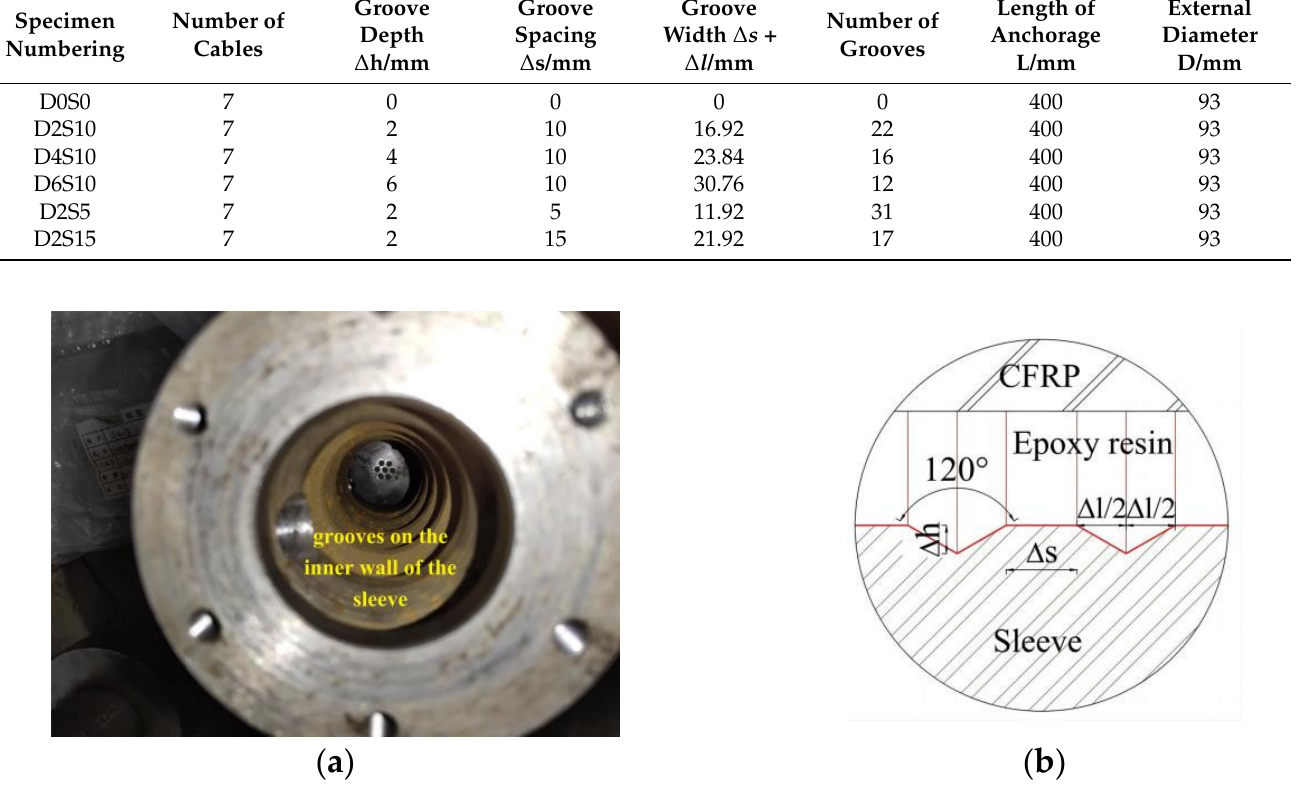
Figure 3. Groove on the inner wall of the sleeve: ( a ) vertical view through the entrance of the sleeve; ( b ) dimension of the groove. Table 2. Specimen parameters of static tensile test